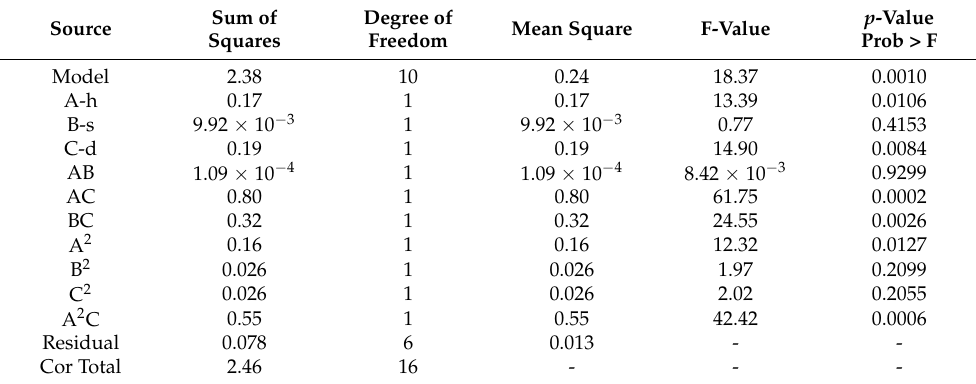
Table 5. ANOVA for response